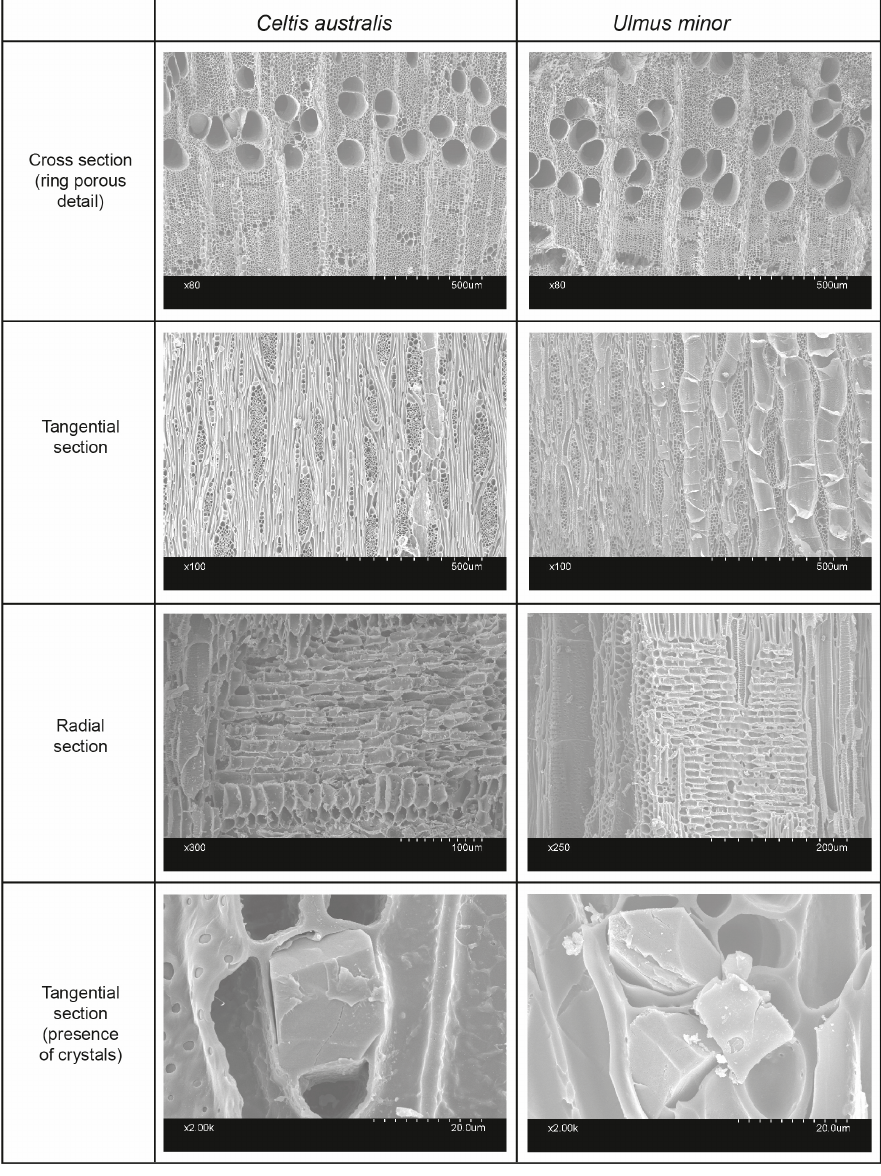
Figure 2. Comparison of the wood anatomy of Celtis and Ulmus .